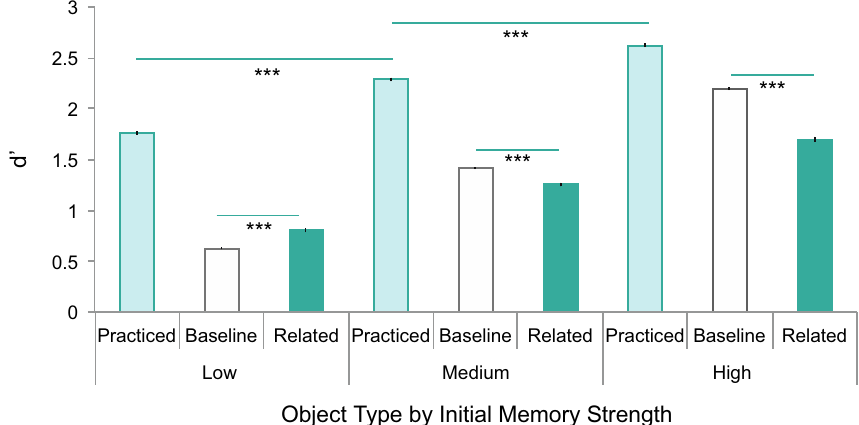
Figure 2. Fukuda, Pall 8 d ′ data sorted by object type across low-, medium-, and high-strength conditions. Initial memory strength categories were determined using baseline performance (white bars). Error bars represent standard error. Induced forgetting is reliable in the medium- and high-strength conditions, with the magnitude of induced forgetting larger in the high-strength condition. The benefit of practice reliably increases across all three conditions. Rather than practice inducing forgetting in the low-strength condition, practice had the opposite effect, reliably increasing memory for related